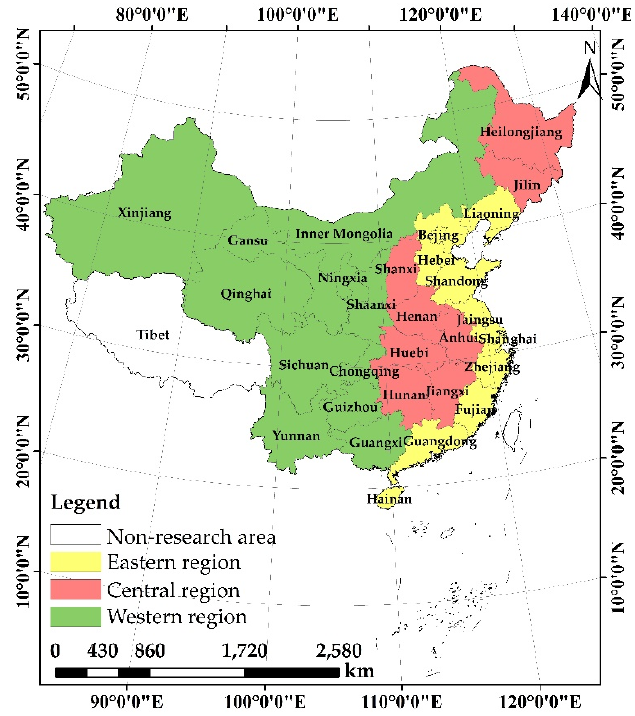
Figure 1. The distribution of the three regions of mainland China.